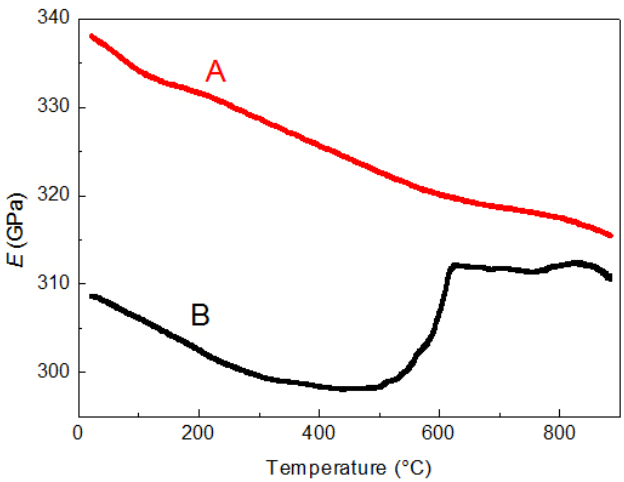
Figure 8. Dynamic modulus vs. temperature curves of tungsten samples ( A and B ) prepared by two different companies.